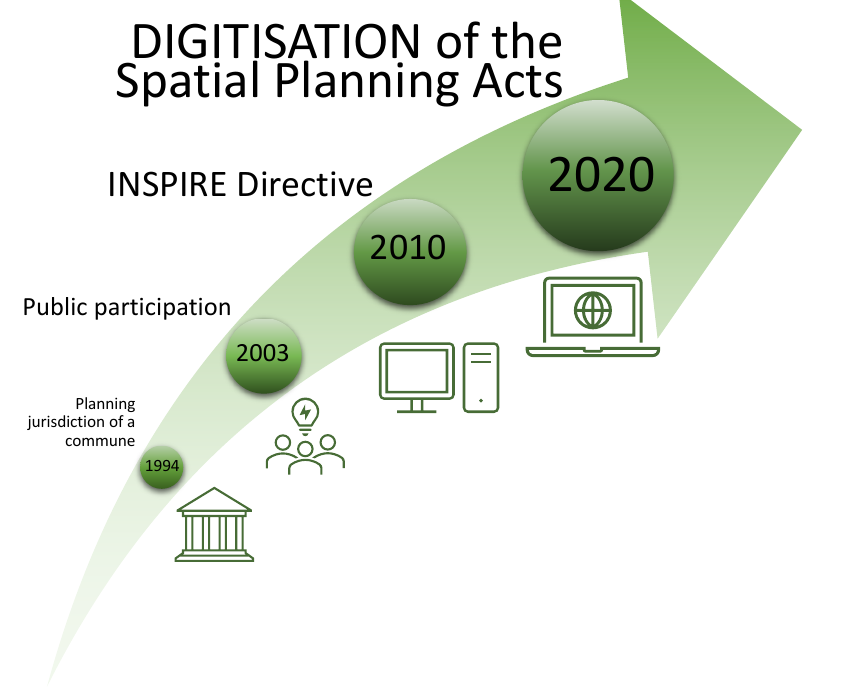
Figure 1. Milestones in the evolution of spatial-planning